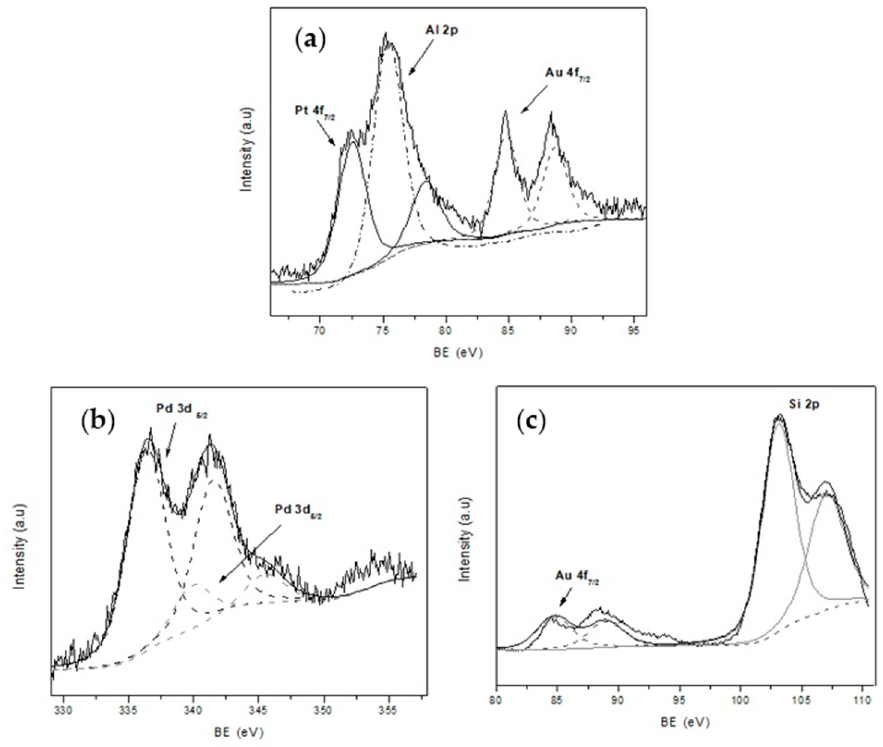
Figure 6. X-ray photoelectron spectroscopy (XPS) spectra of bimetallic catalysts; ( a ) Au-Pt- ZSM-11; ( b ) and ( c ) Au-Pd-ZSM-11.